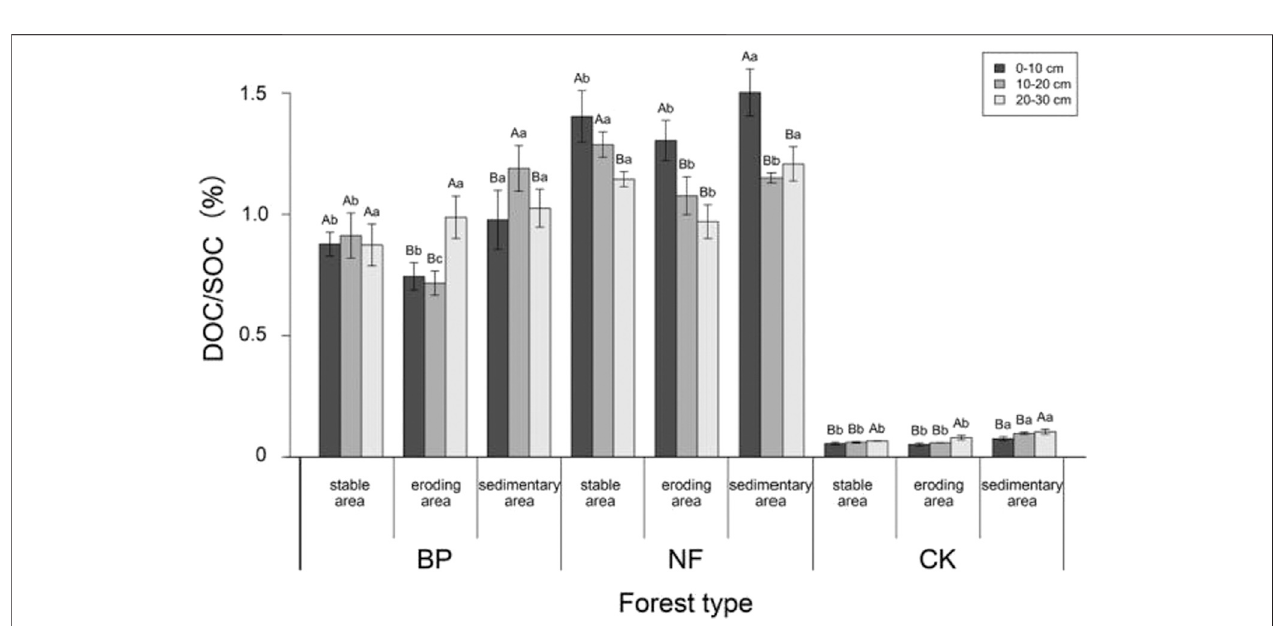
FIGURE 4 | Ratio of dissolved organic carbon (DOC) to total soil organic carbon (SOC) of the 0 – 30 cm soil layer (in 10 cm intervals) in three areas under different foresttypes.Verticalbarsrepresentthestandarddeviationsof fi vereplicatedsoilsamples.Differentcapitallettersforthesameareasindicatesigni fi cantdifferencesat p < 0.05 of soil layers, while different lowercase letters for the same soil layers indicate signi fi cant differences at p < 0.05 of different regions.